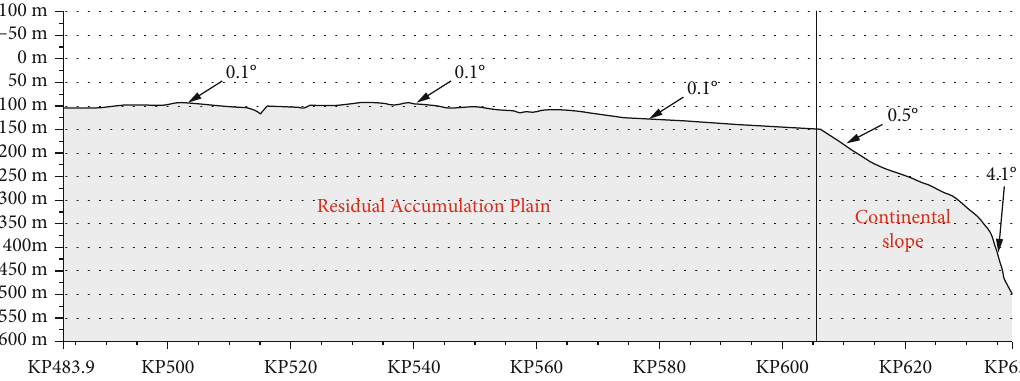
Figure 7: Sandwave images showed by side-scan sonar (the left is located in the large erosion depression landform area, and the right is located in the stacked terrace landform